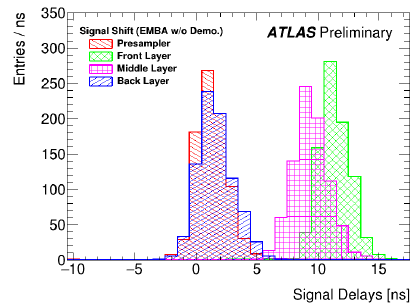
Figure 7: The signal delays introduced by the Phase-I front-end elec- tronics for L1Calo trigger signals, collected from all trigger towers in EMBA [10]. Signals from the region 0 < η < 1 . 5 and 1 . 8 < η < 2 . 2 are excluded, since these were covered by Phase-I test electronics which were installed during